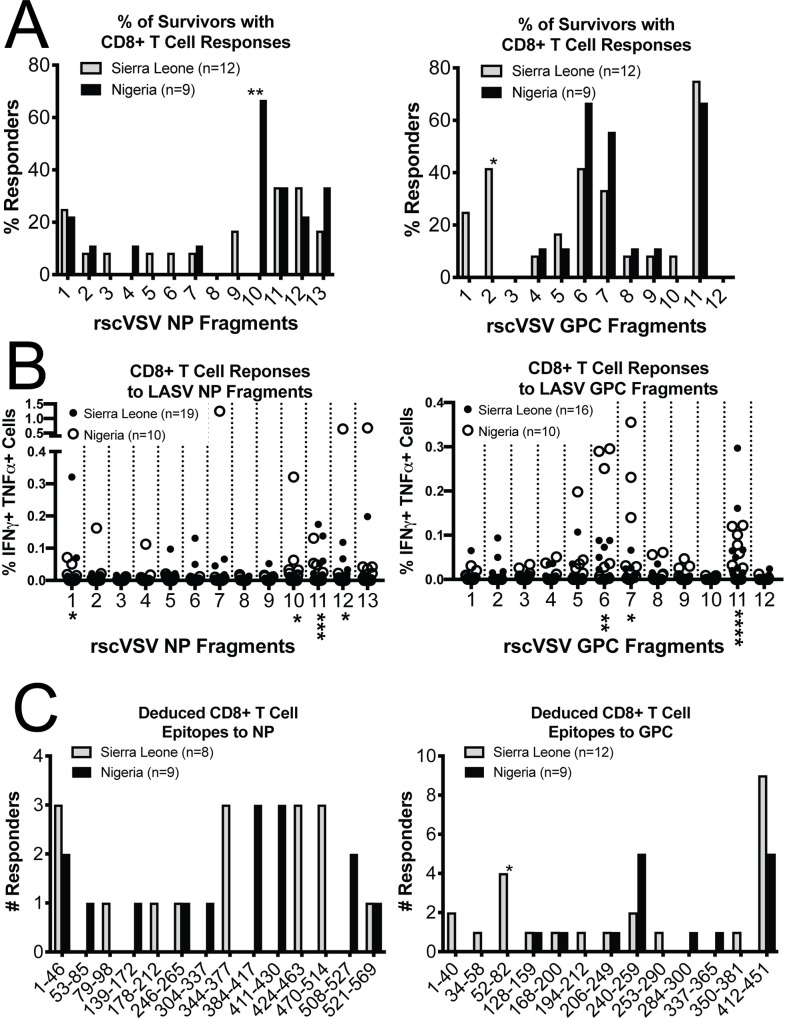
CD8+ T cell responses to discrete regions within LASV NP and GPC.A) rscVSVs encoding for ~60aa polypeptides (fragments) from LASV NP and GPC (Josiah strain) were incubated overnight with PBMCs from LF survivors from Sierra Leone (grey) and Nigeria (black) in the presence of brefeldin A. Percentage of individuals who harbor CD3+CD8+ T cells expressing IFN-γ and TNF-α in response to each fragment is shown. Only individuals who responded to at least one LASV antigen are shown. Statistical significance was calculated comparing responses from Sierra Leonean (grey bars) and Nigerian (black bars) survivors using two-tailed t test. (B) Percentages of CD3+ CD8+ T cells expressing IFN-γ and TNF-α subtracted from negative controls from all LF survivors are shown whether or not each individual was considered to have responded to the whole antigen. Responses from Nigerian survivors (open circles) and Sierra Leonean survivors (closed circles) are shown for each rscVSV encoding NP and GPC ~60 amino acid fragments. Statistical significance was calculated using one-way ANOVA (Friedman test). C) Data from CD8+ T cell responses to fragments was used to deduce epitopes. If two adjacent fragments elicited a similar response, the overlapping area was considered an epitope region. If a fragment elicited a response while adjacent fragments elicited a null response, the epitope region was considered to be the non-overlapping regions plus seven amino acids into overlapping regions on either side. Statistics using two-tailed t test comparing Sierra Leonean and Nigerian groups are shown. For all statistical analyses, lack of asterisk indicates no significance; ***p<0.0001, **p<0.005, *p<0.05.